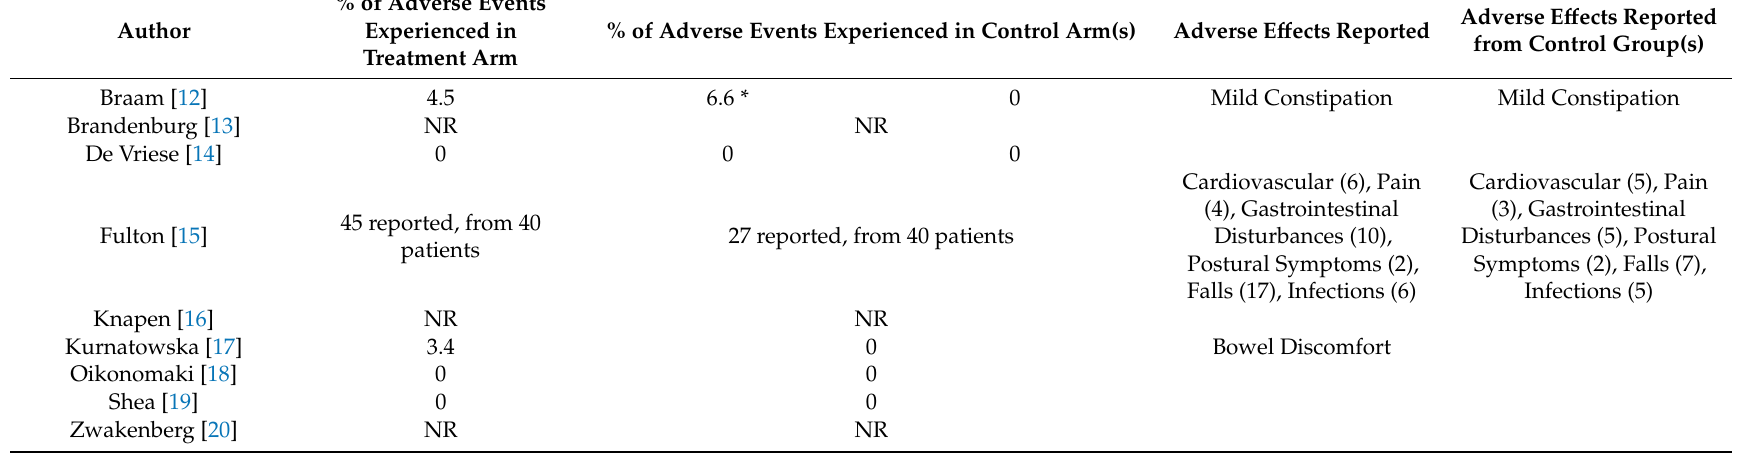
Table 8. Frequency and type of adverse events experienced by trial